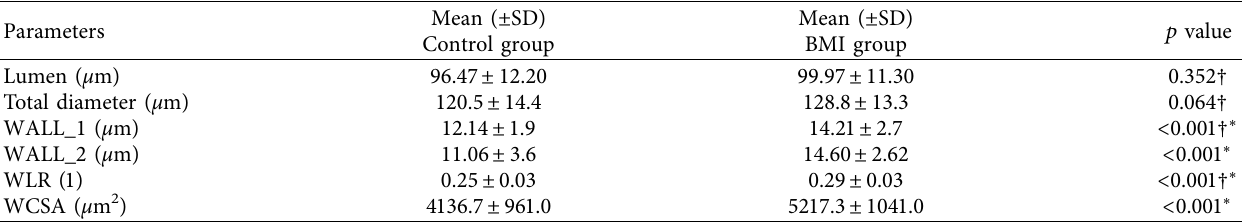
Table 6: Characteristic of retinal artery parameters in the BMI and control groups ( n � 28 and n � 19) after Bonferroni correction (adjusted p value �